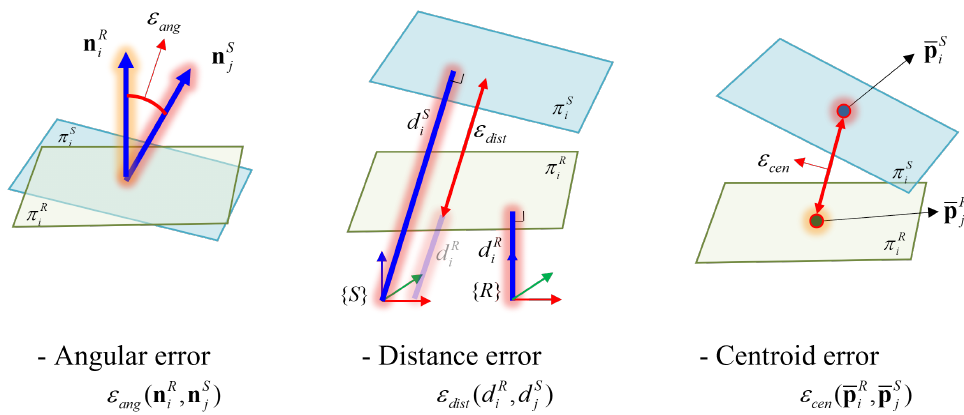
Figure 3. The test measures for assigning plane correspondences using the plane parameters ) between the target and To detect corresponding planes, similarity distance D ( π R , π S i j query plane, which is the weighted sum of the test measures, is calculated for all possible pairs of planes based on a brute-force search (line 9). w represents a weight for each test measure. Subsequently, the pair of planes with the smallest weighted sum is detected as plane correspondence (line 12). c i denotes the corresponding plane of the i -th target plane. If the similarity distance is above specific threshold value D max , the pair of planes is rejected from the iteration of the calibration